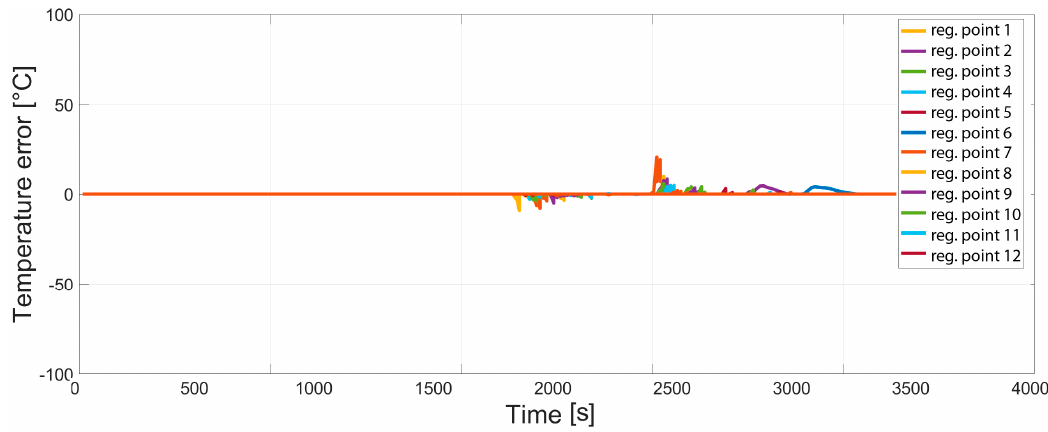
Figure 10. Surface temperature errors after each cooling loop.